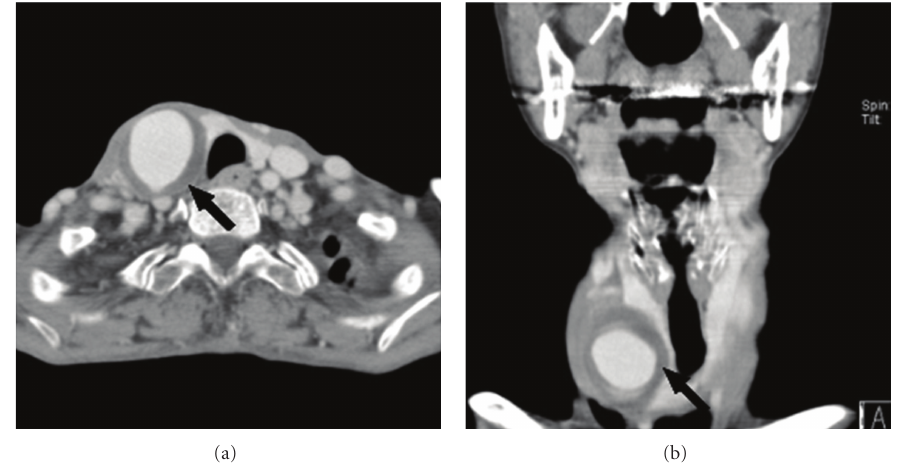
Figure 3: ((a) and (b)) Contrast-enhanced CT angiograms demonstrating a 2.5 × 3.4cm sized thrombosed pseudoaneurysm (arrow) in the right common carotid